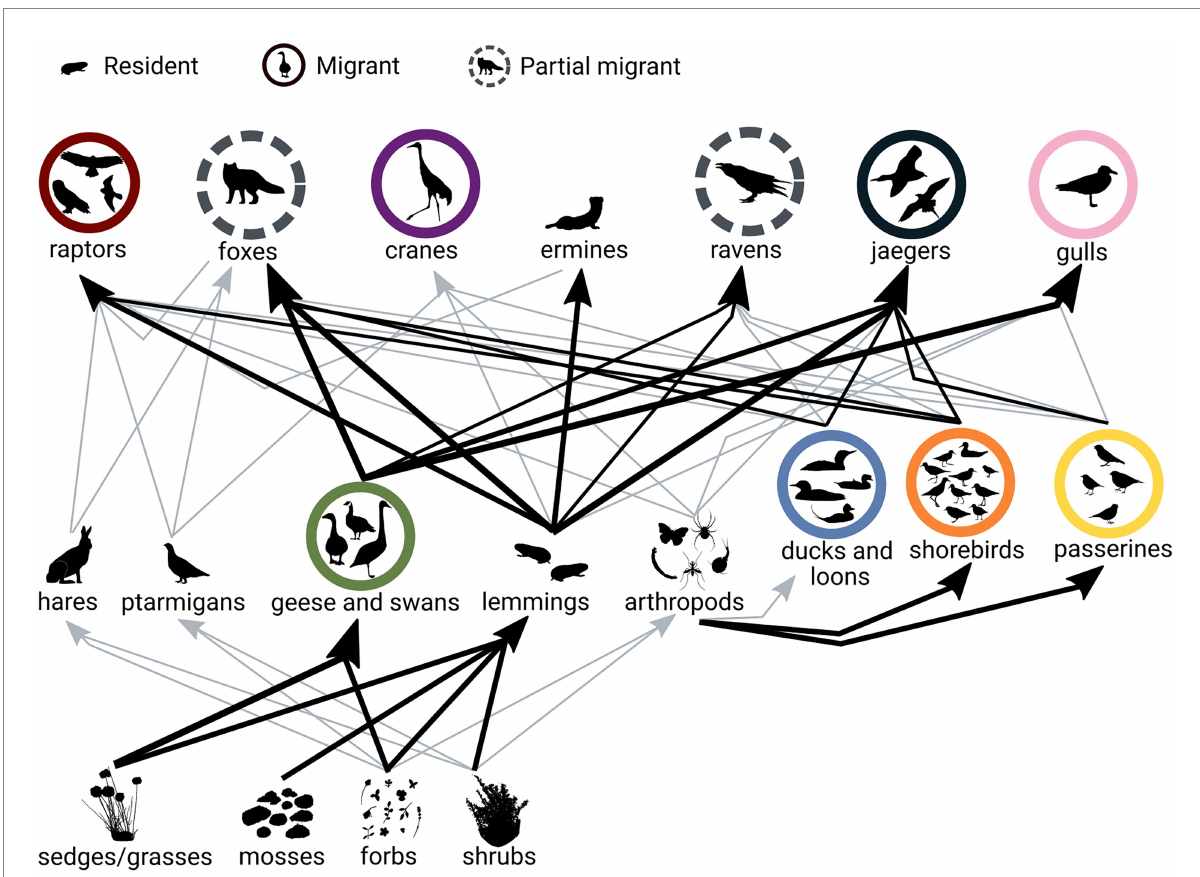
FIGURE 1 Bylot Island tundra food web adapted from Gauthier et al. (2011). Labels represent the functional groups, and the groups composed of migratory species are colored (red = raptors, pink = gulls, purple = cranes, dark blue = jaegers, light blue = ducks and loons, orange = shorebirds, yellow = passerines, green = geese and swans). The species composition of vertebrate functional groups is represented by icons (e.g., four species of passerines). Arrows represent biomass flow between functional groups and the size of the arrows is relative to the proportion of the diet; gray arrows represent minor portions of the